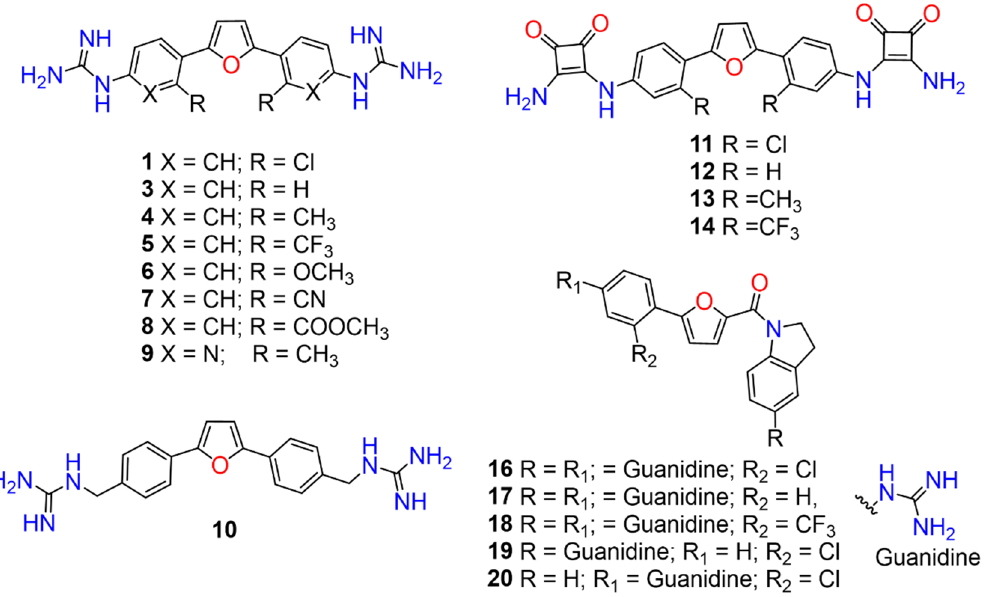
Figure 2. Chemical structures of the synthesized guanidium-arylfurans ( 1 , 3 – 10 , 16 – 20 ) and squaramides-arylfurans ( 11 – 14 ).